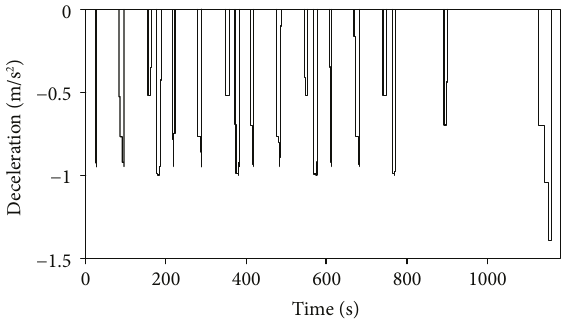
Figure 11: Braking deceleration diagram of NEDC